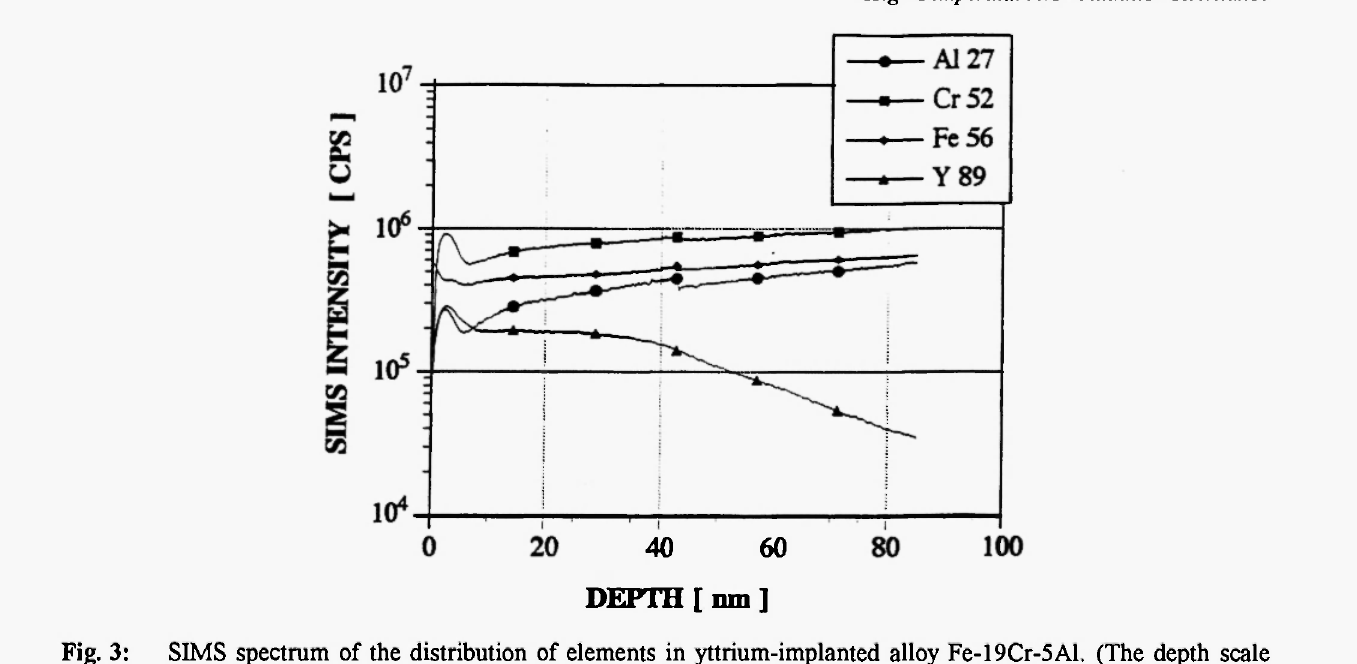
40 60 D E P TH [ n m] Fig. 3: SIMS spectrum of the distribution of elements in yttrium-implanted alloy Fe-19Cr-5Al. (The depth scale was calculated assuming the same sputter rate as determined for standard sample consisting of TaiOs layer on Ta derived using the same analysis parameters.)